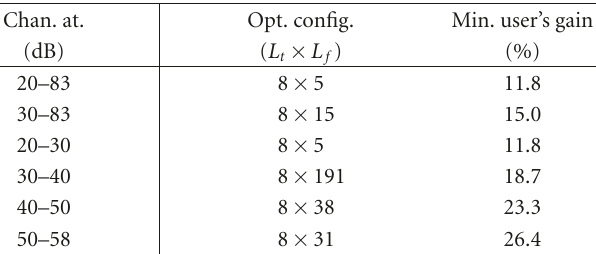
Table 1: SS-OFDM optimal configuration and minimum user’s throughput gain versus channel